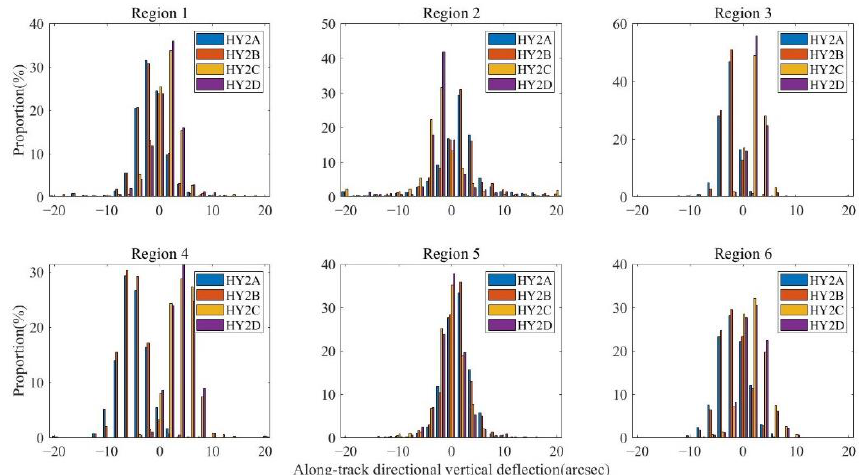
Figure 10. Distributional proportion of HY-2 along-track vertical deflections over study regions (unit: arcsec): Region 1, North Pacific; Region 2, South Pacific; Region 3, Mid-Pacific; Region 4, Indian Ocean; Region 5, North Atlantic; Region 6, South Atlantic.